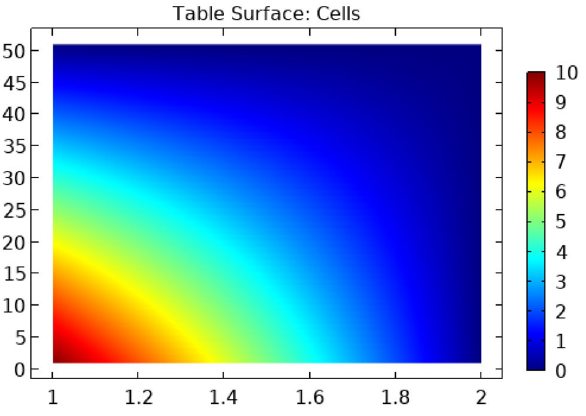
Figure 19. Surface graph of drag coefficient in squared cylindrical